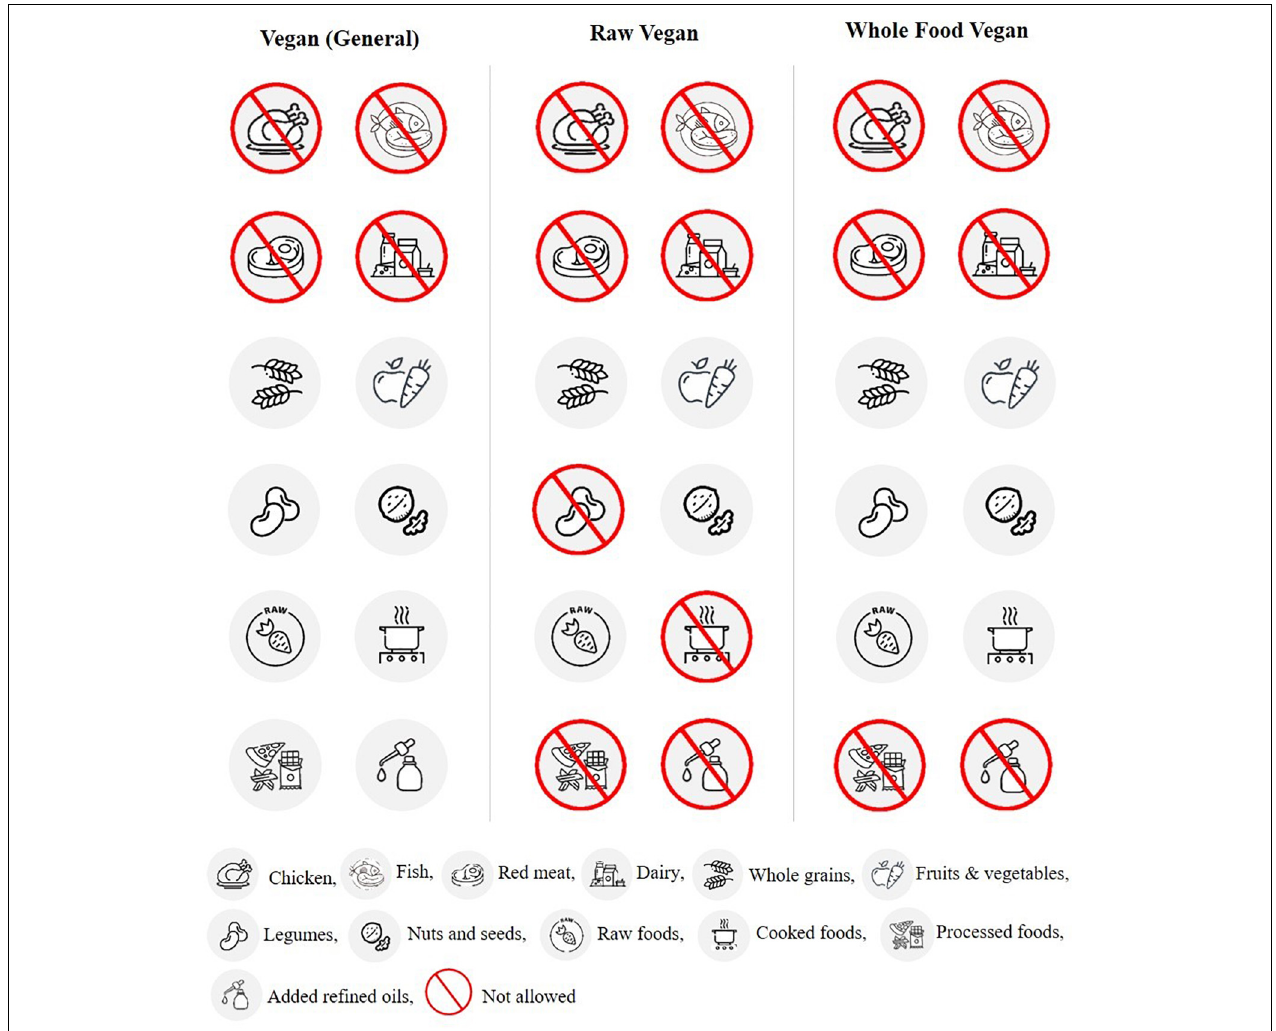
FIGURE 2 | Foods allowed and restricted in vegan